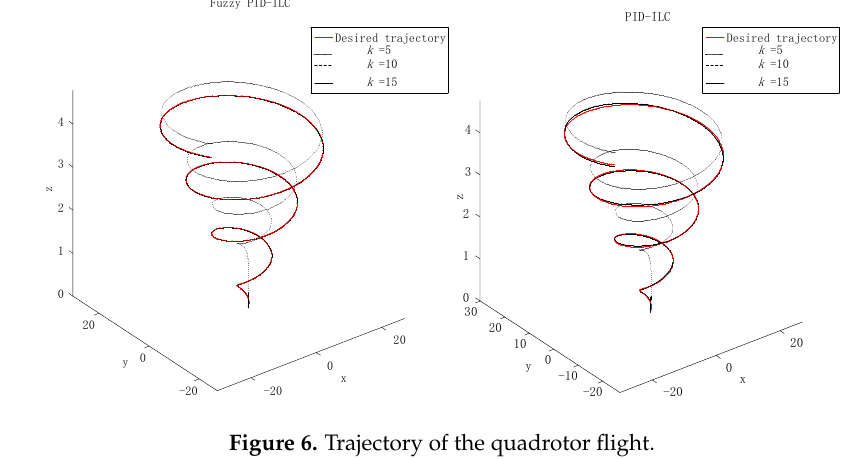
Figure 5. The flying process of the quadrotor aircraft in the Gazebo simulation environment.